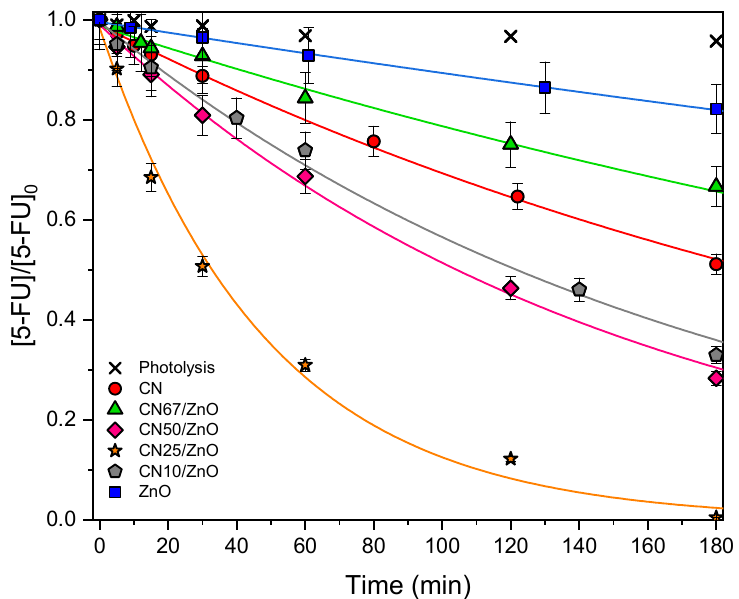
Figure 6. Photocatalytic degradation of 5-FU at natural pH as a function of time for pure CN, pristine ZnO, and CN/ZnO composites. Curves represent the fitting of the pseudo-first order equation to the experimental data. Table 2. The 5-FU conversion after 180 min (X 5-FU ), pseudo-first order kinetic rate constant ( k’ ap ), coefficient of variation ( k CV ), and regression coefficient (r 2 ) of 5-FU.